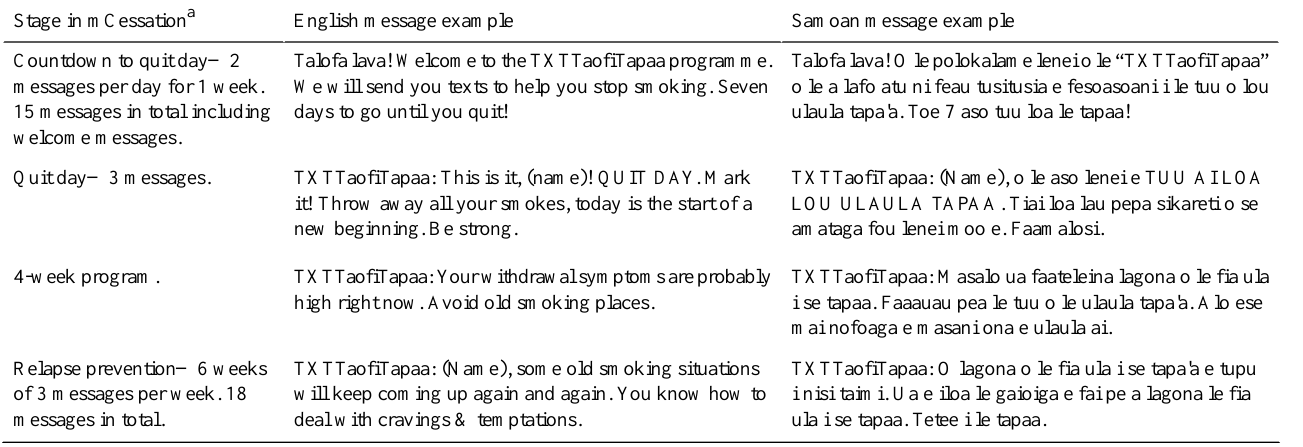
Table 2. Example of short message service text messages translation and adaptation for each stage of the program.